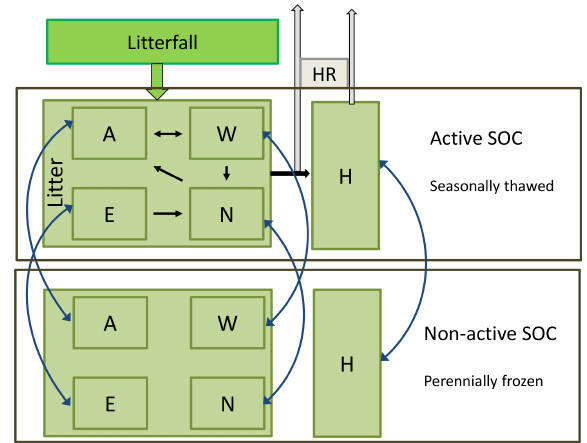
Figure 1. Extended soil carbon pool structure in JSBACH account- ing for active layer and permafrost carbon (modified from Goll et al., 2014). In YASSO, soil organic matter (SOM) is separated into groups of different chemical compounds (A, W, E: labile pools), an intermediate pool (N), and a slow pool (H). Carbon gain results from litter input, carbon loss from heterotrophic respiration (HR) in active layer pools. Changes in maximum seasonal thaw depth in- duce a transfer of carbon (blue arrows) from non-active to active pools (warming), and vice versa